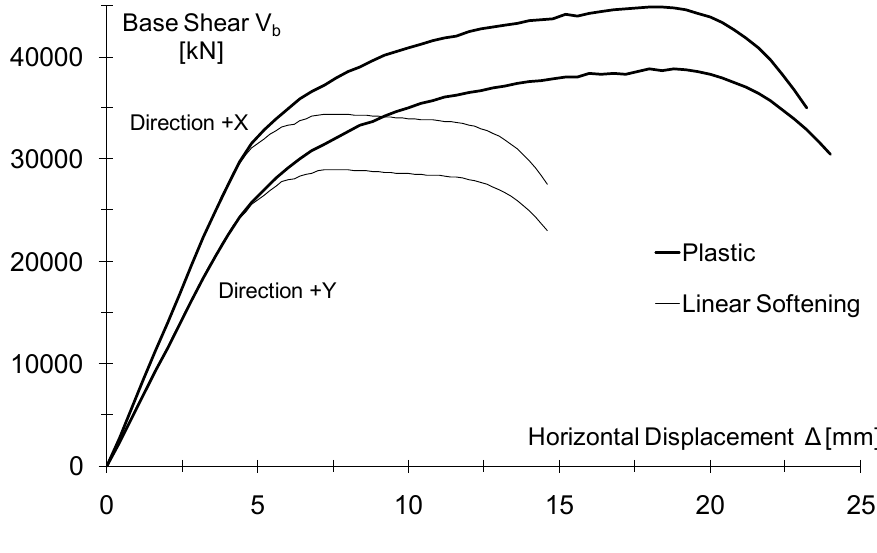
Figure 12. Capacity curves in direction +X and +Y for two different constitutive laws under